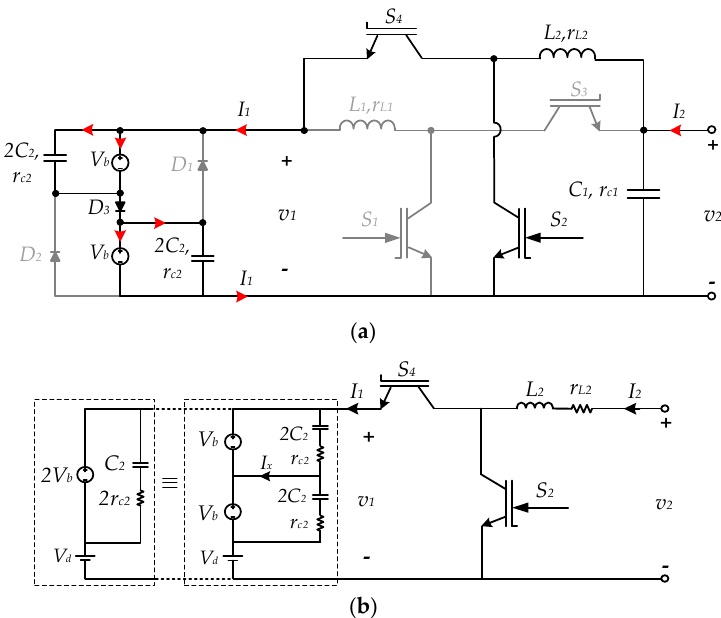
Figure 5. Charge mode circuit. ( a ) Current flow diagram; ( b ) equivalent circuit.